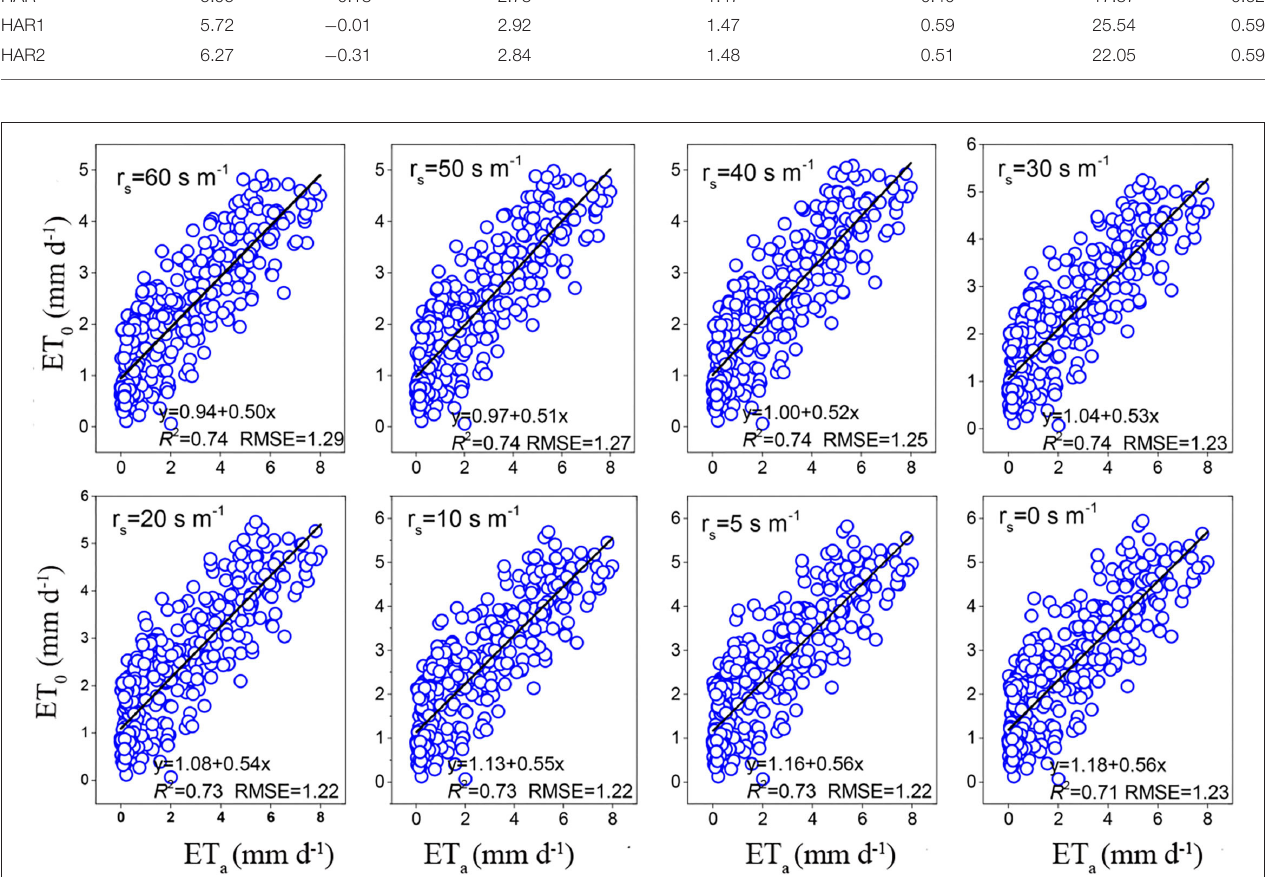
FIGURE 4 | Effect of different surface resistances on daily estimates of the FAO56 Penman–Monteith.